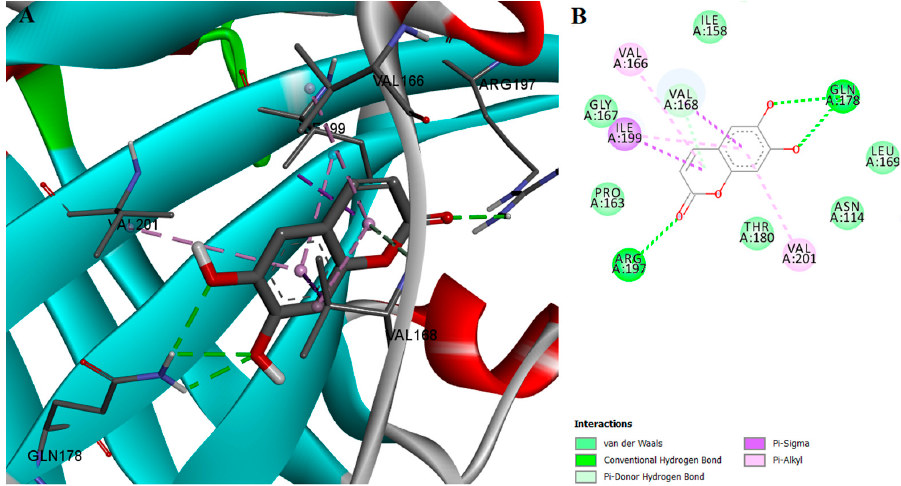
Figure 4. ( A ) Docked conformation and interactions of the esculetin-SrtA complex; ( B ) 2D diagram of the predicted interactions; backbone of the protein is colored in grey, β -helices in turquoise, α -helices in red and loops in green. Ligand-protein interactions are colored depending on their type: conventional hydrogen bonds are colored in green, π - σ and π -alkyl interactions are colored in purple and light purple, respectively.